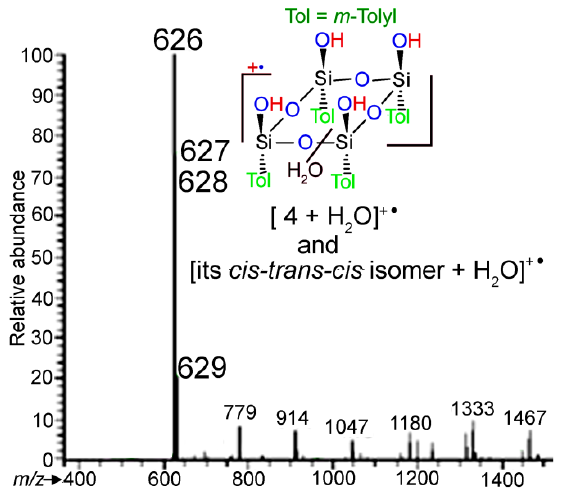
Figure 4. PI APCI mass spectrum of the precipitate separated from the reaction mixture after the hydrolysis–conduction reaction of 1 was carried out at C HCl = 0.054 mol L −1 for 120 h.